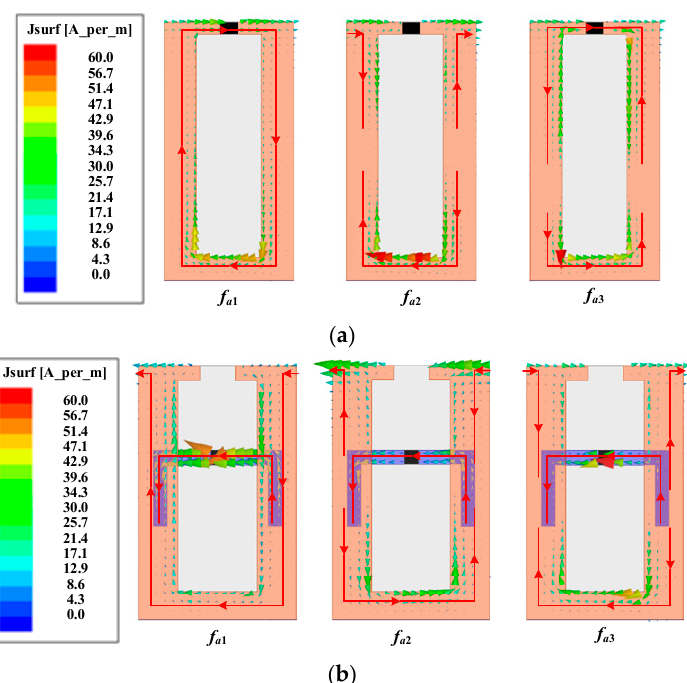
Figure 4. Current distribution of ( a ) the original lossy slotline and ( b ) the proposed 3D